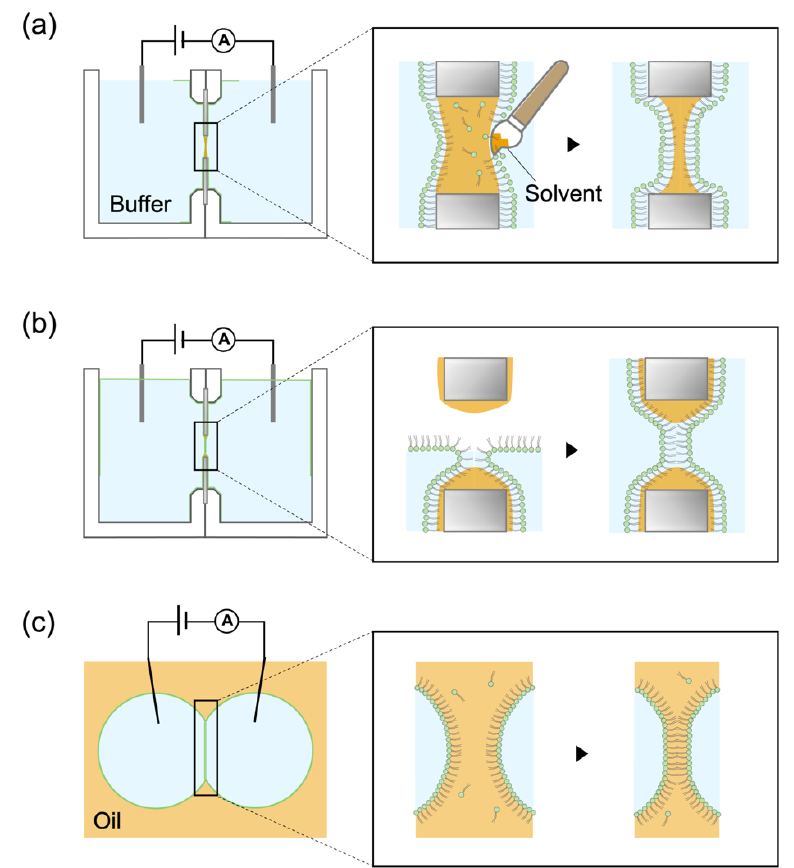
Figure 2. Schemes showing three methods for the formation of BLMs (not to scale): ( a ) painting method [20]; ( b ) monolayer folding method [22]; ( c ) droplet interface bilayer (DIB) method [27]. In the DIB method, BLMs are formed by bringing two lipid-coated aqueous droplets into contact in an oil phase. Reprinted with modification from ref. [6]. Copyright 2020 WILEY.